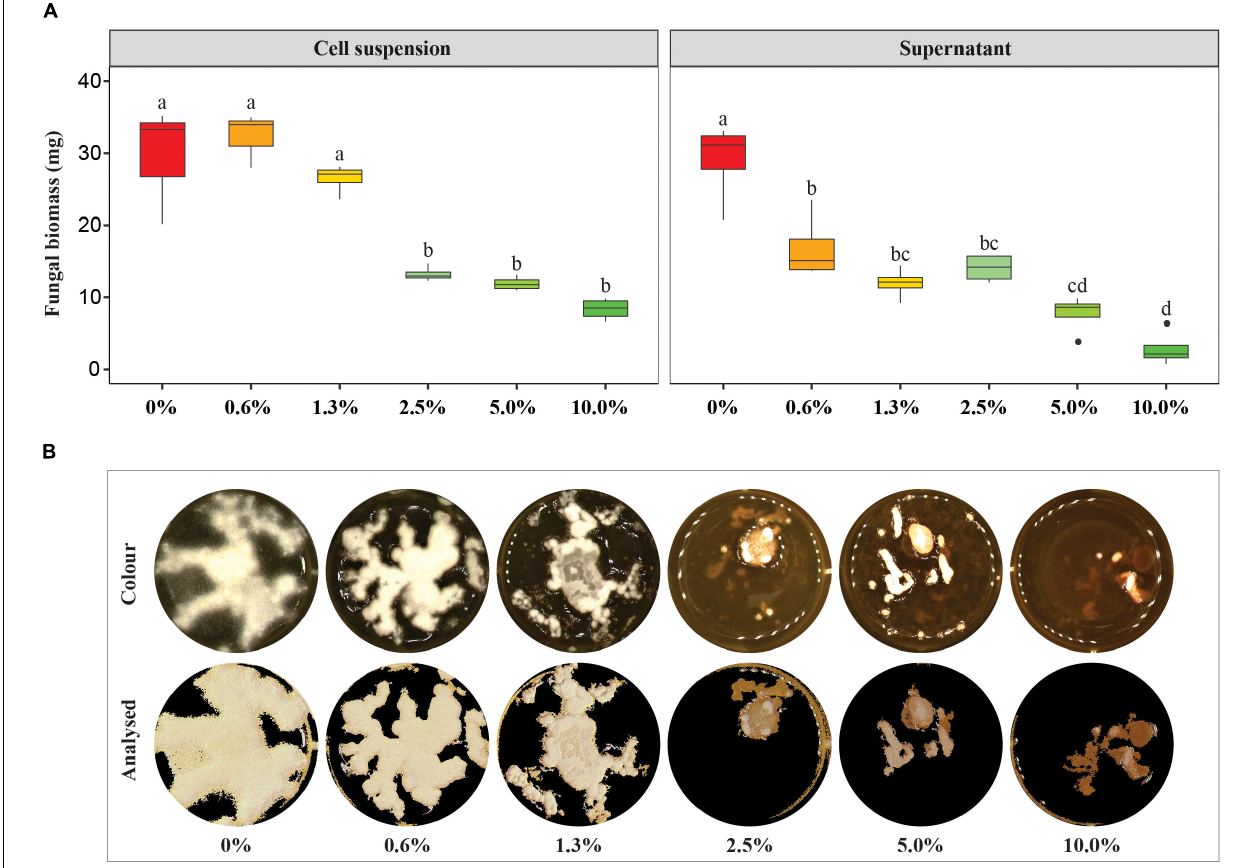
FIGURE 2 | Impact of the Streptomyces strain ST03 on the production of biomass of Fusarium verticillioides in liquid medium. (A) Dried F. verticillioides biomass (g) by treatments. An initial concentration of the cell suspension was 5 × 10 7 CFU mL - 1 , the supernatant was concentrated 10 times before application. Different letters above each box depict the significant difference between treatments using an ANOVA test and a post hoc Turkey test at a significant level of α = 0.05. A mock control (0% treatment) was inoculated with tryptic soy broth (TSB). (B) Growth surface of F. verticillioides in tryptic soy broth supplemented with the supernatant at different concentrations ranging 0 – 10% at 7 days of inoculation. Four biological replicates were done per treatment. The experiment was repeated